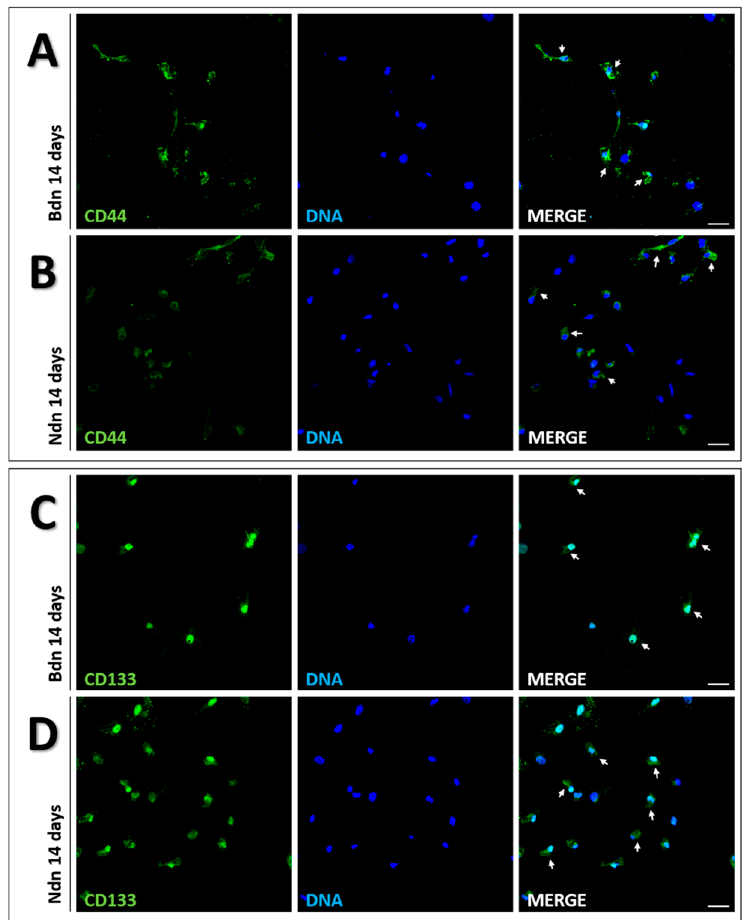
Figure 6. Immunofluorescent localization of CD44 (lines A , B ) and CD133 (lines C , D ) in poPSCs after 14 days of culture in the presence of boldenone at a dose of 100 µM (lines A , C ) and nandrolone at a dose of 35 µM (lines B , D ). Green signal—AlexaFluor 488 fluorescent dye, blue signal—DAPI, scale bars represent 100 µm. The immunofluorescence staining was repeated thrice; the figure shows the best representative micrographs selected from 3 replicates.